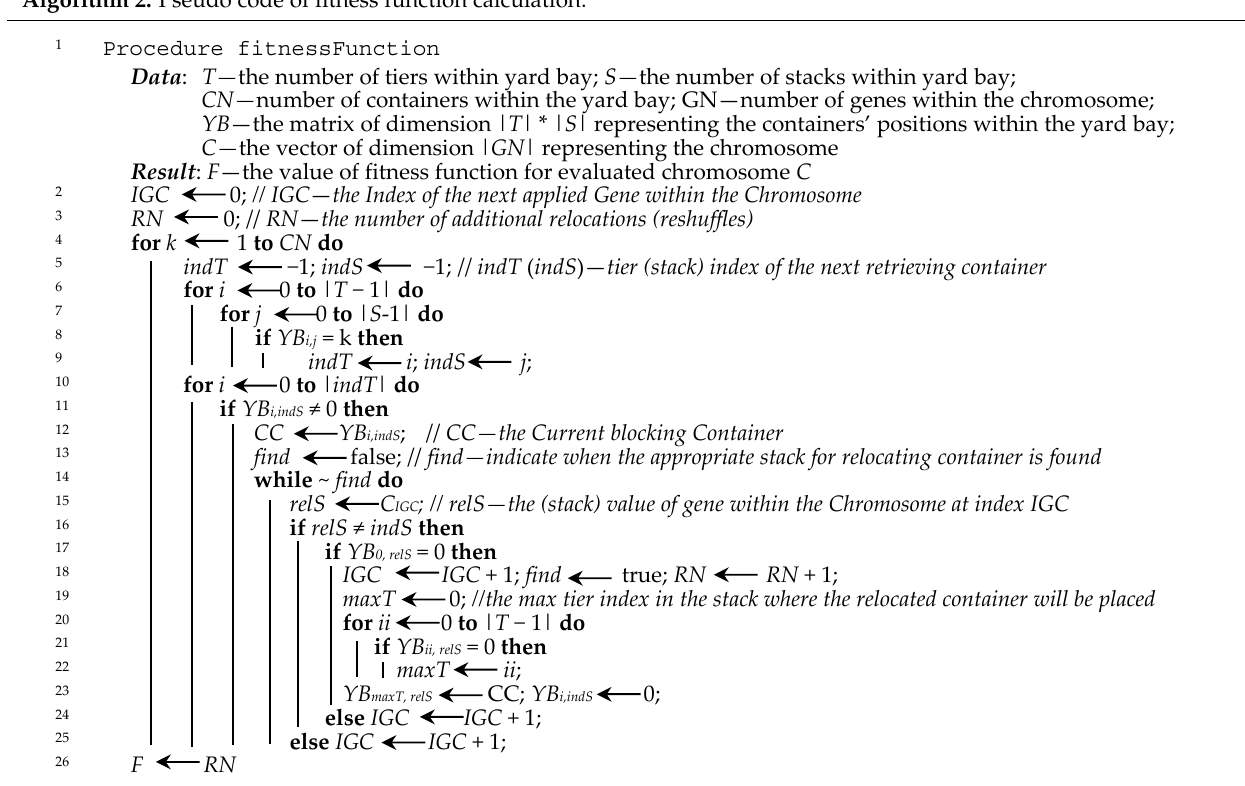
Algorithm 2. Pseudo code of fitness function calculation. Procedure